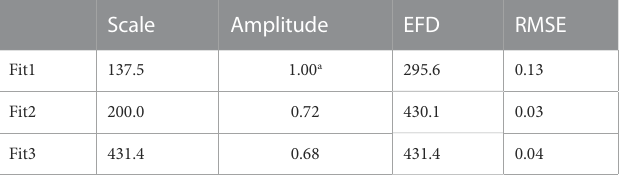
TABLE 1 The scale parameter ( α − 1 ), amplitude ( A ), effective e-folding distance (EFD),androot-mean-squareerror(RSME)forthree fi tstohorizontalsnow-depth correlations. All units are in km except for the dimensionless